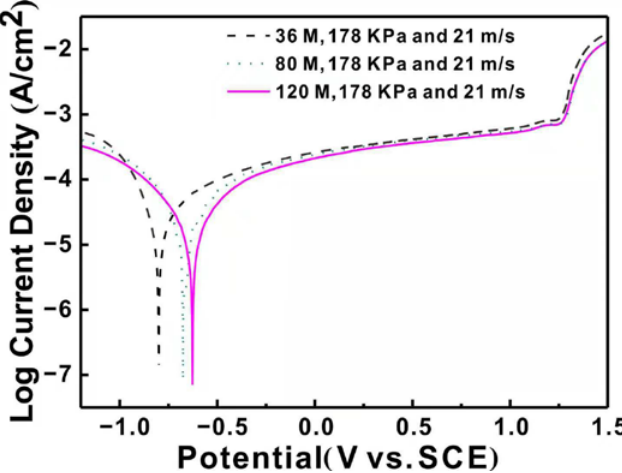
Figure 2. Potentiodynamic polarization curves of the ground surface with different abrasive particle sizes. Saturated Calomel Electrode (SCE).